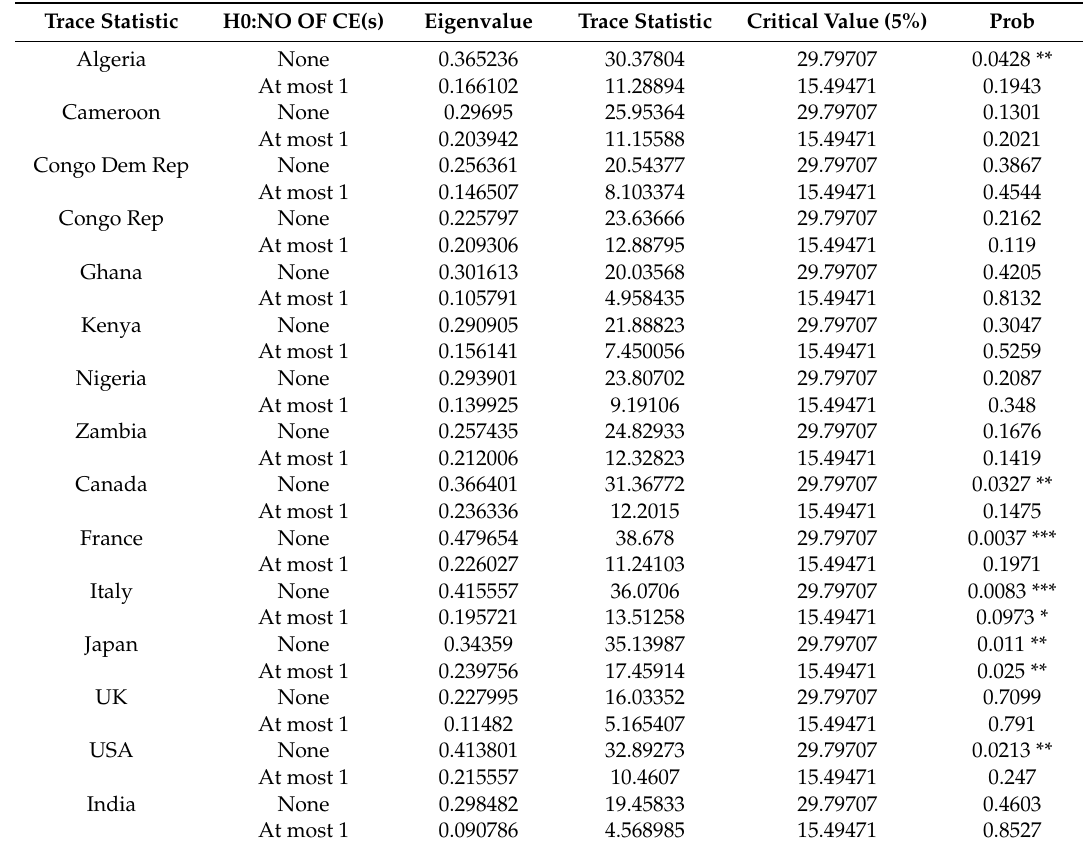
Table 4. Cointegration test